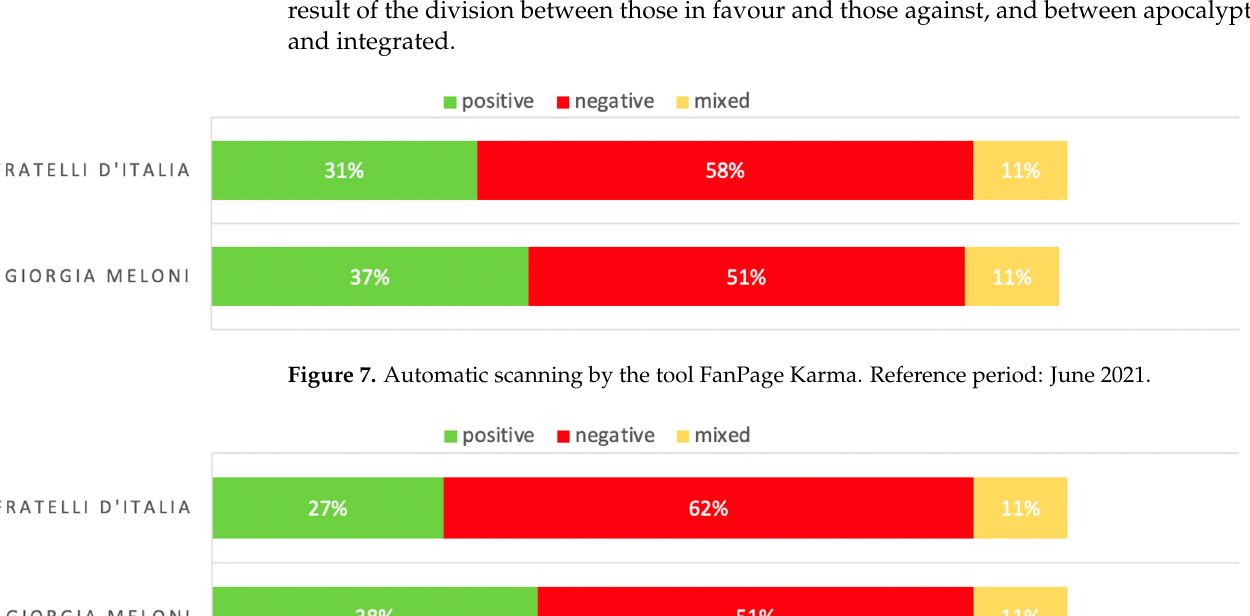
Figure 6. Automatic scanning sources of spoken language by the tool FanPage Karma. Reference